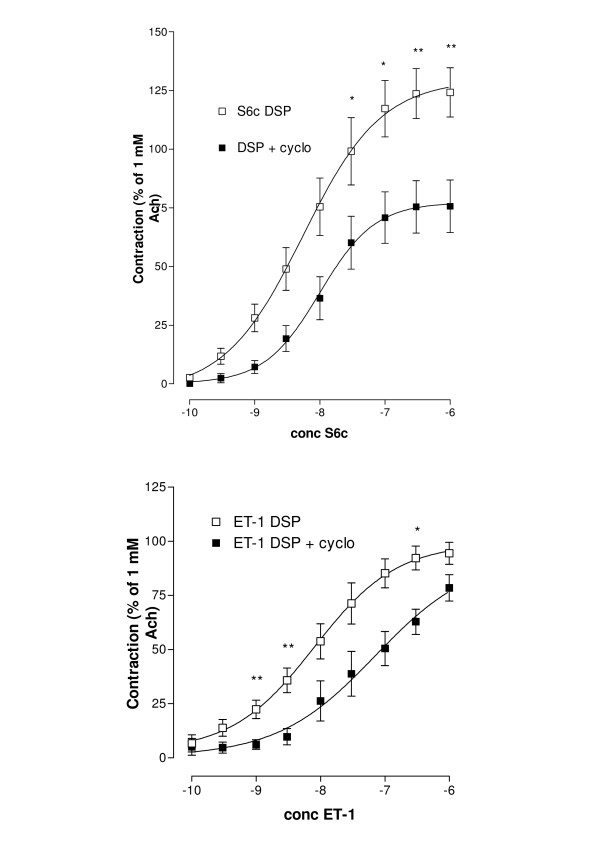
Translational inhibitor (cycloheximide) effect on DSP led to changes in ET-1 and S6c contractility. Rat bronchial segments were incubated for 24 hours in DSP in two groups. In the one group a translational inhibitor (cycloheximide, 10 μg mL-1) was added. Two-way  Anova with Bonferroni post test was used to compare contraction at different  concentrations of agonist. * P < 0.05.